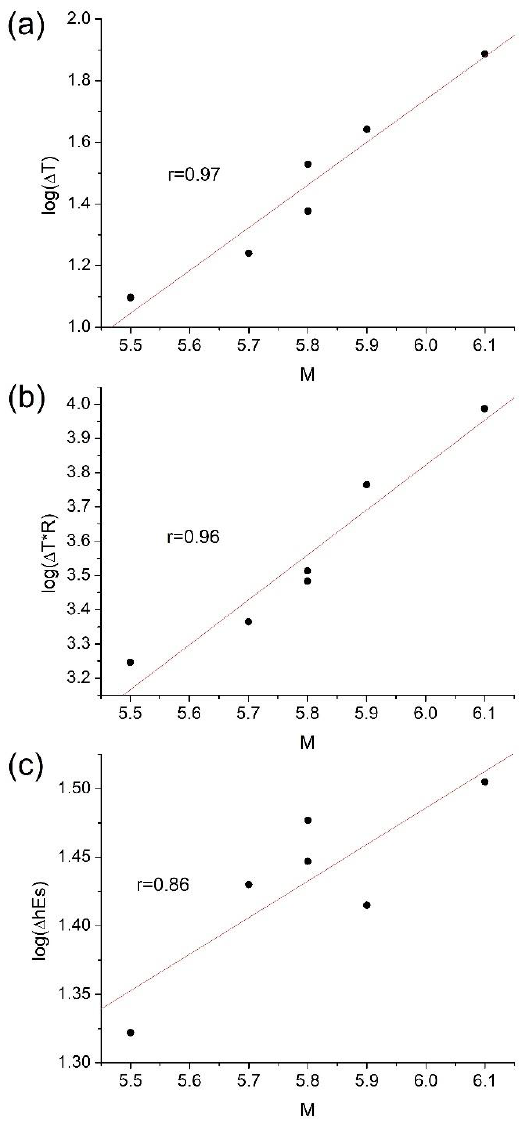
Figure 2. The observed dependencies for ( a ) log(ΔT), ( b ) log(ΔT·R), and ( c ) log(Δ h ’Es) on the EQ magnitude M. Solid lines—linear regressions. Correlation coefficients, r, are given.